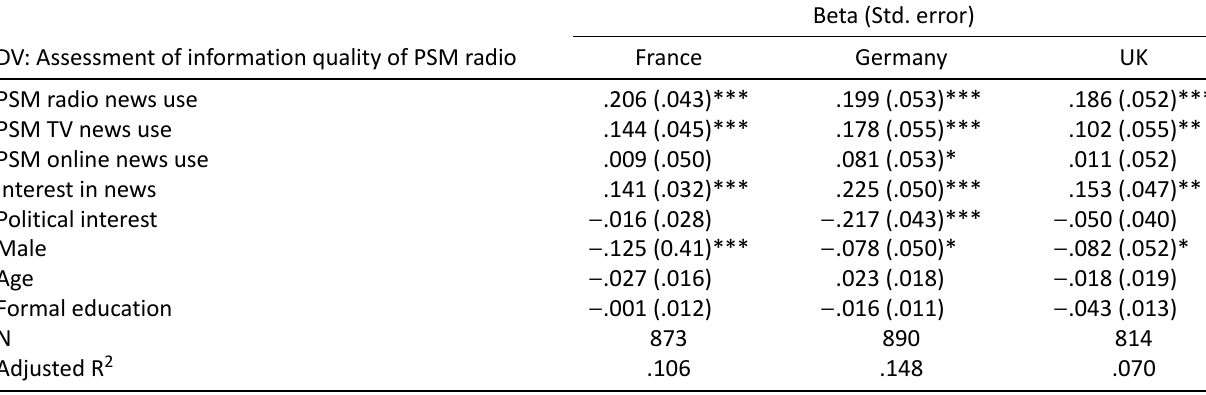
Table 4. Effects on the assessment of information quality of PSM radio in France, Germany, and the UK (multiple linear regression).